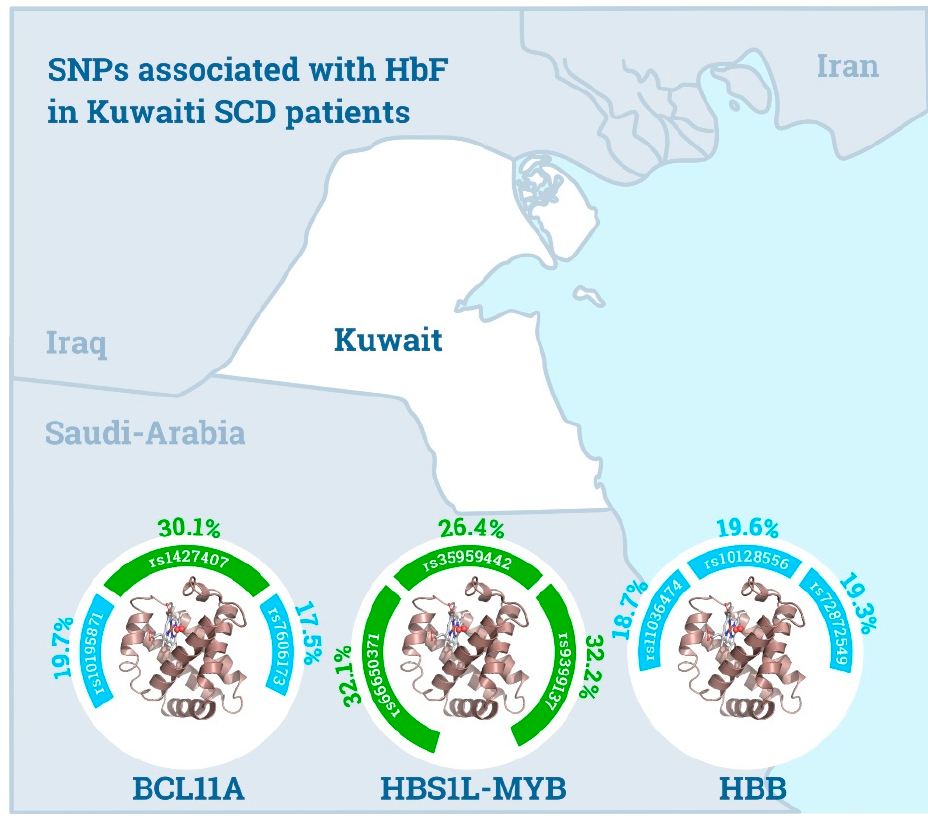
Figure 2. Schematic summary of variants affecting HbF levels in Kuwaiti SCD patients. The green arch represents the association with HbF-2 and HbF-3; the blue arch represents the association with HbF-1. Table 3. Previously Unpublished Variants in HBS1L-MYB , and HBB loci showing significant association with HbF in Kuwaiti patients with SCD.